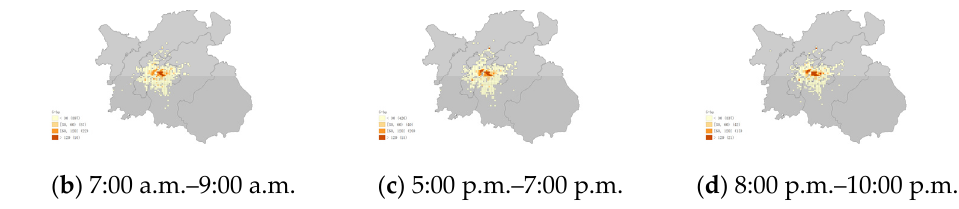
Figure 9. ( a ) Grid boarding points (G-bp) of each grid area at 1:00 a.m.–3:00 a.m. ( b ) Grid boarding points (G-bp) of each grid area at 7:00 a.m.–9:00 a.m. ( c ) Grid boarding points (G-bp) of each grid area at 5:00 p.m.–7:00 p.m. ( d ) Grid boarding points (G-bp) of each grid area at 8:00 p.m.–10:00 p.m.